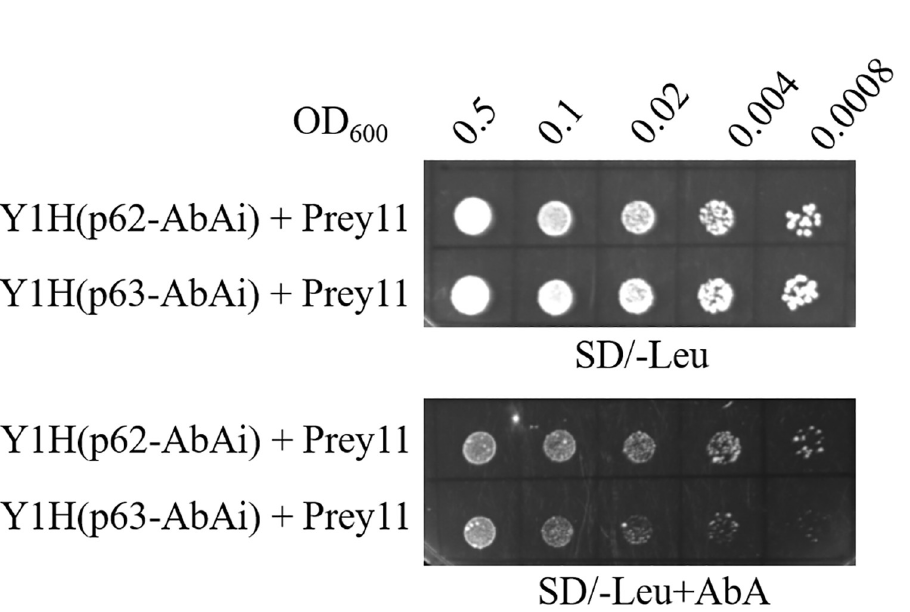
Fig 2. Cotransformation and serial dilution (1:5) with a initial optical density OD 600 ) of 0.5 on selective media to verify the interaction of candidate transcription factor (No. 11). SD/-Leu: synthetically defined medium with dropout leucine, SD/-Leu+AbA: synthetically defined medium with dropout leucine and plus 750 μ g/L Aureobasidin A; Y1H (p62-AbAi): bait strain; Y1H (p63-AbAi): mutant bait strain.